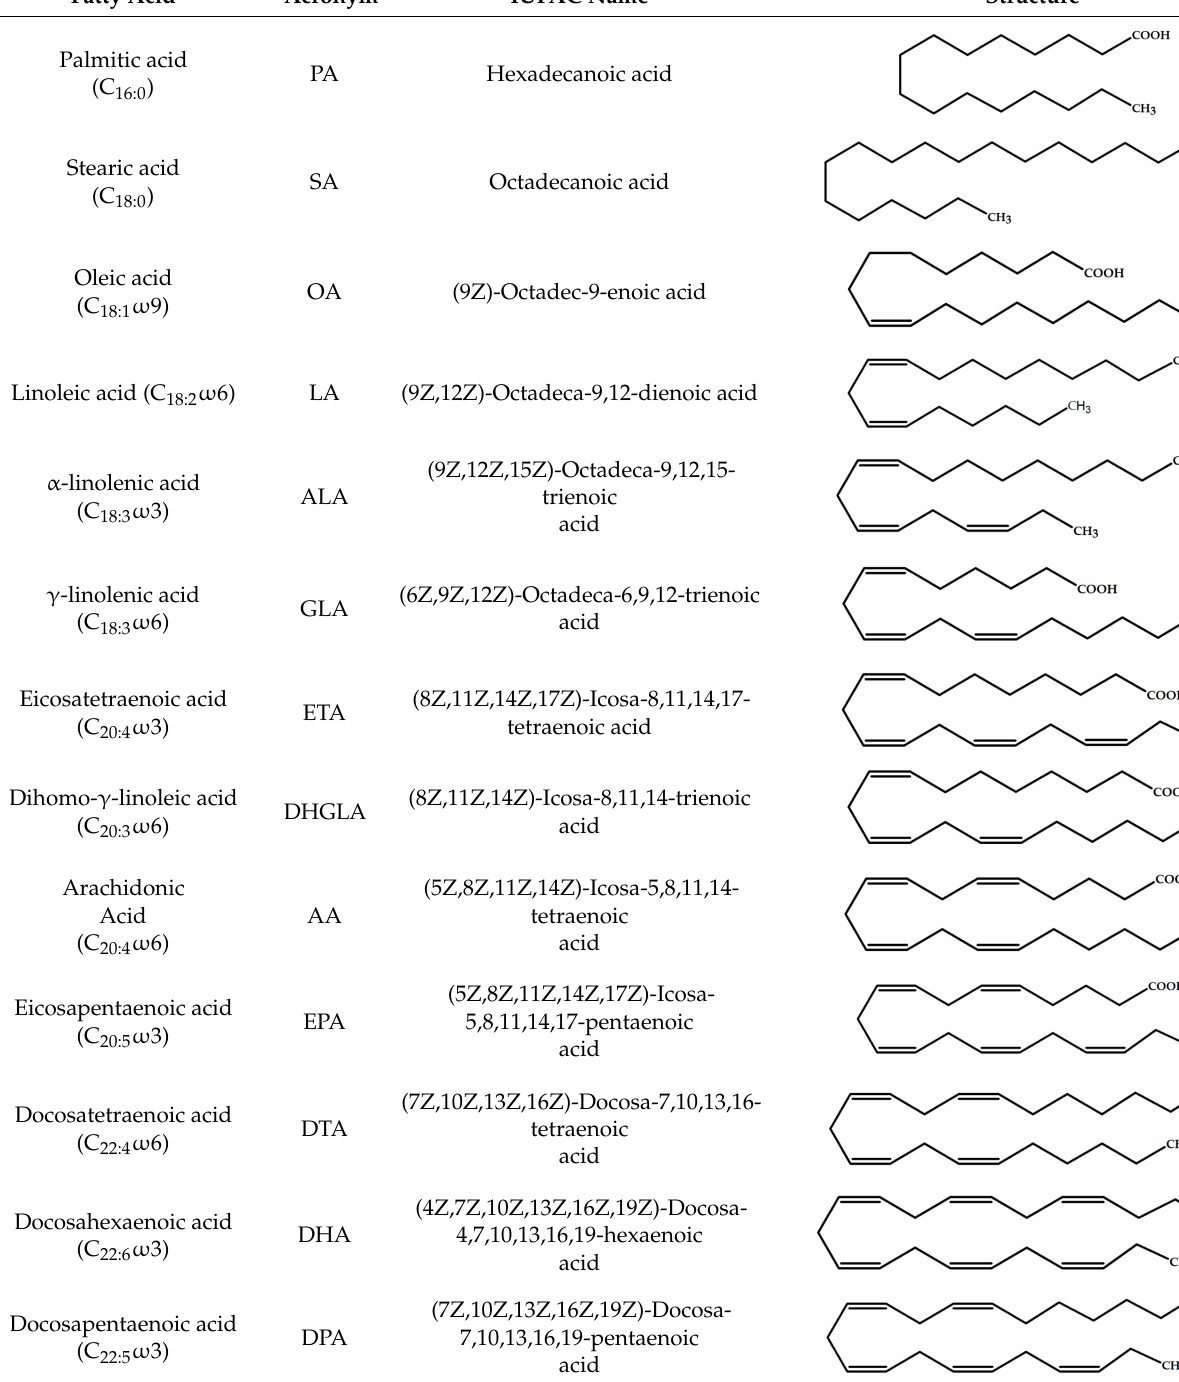
Table 1. Main polyunsaturated fatty acids (PUFAs): common and IUPAC names, acronyms, and structural formulas. Fatty